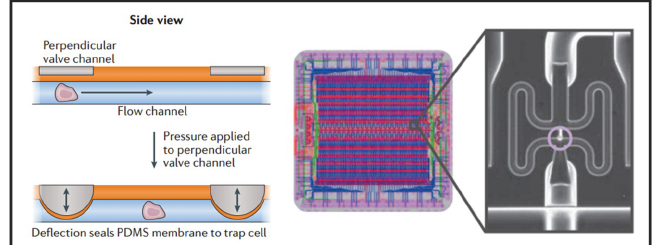
Figure 3. Microfluidic valve single-cell isolation and a design Adapted by permission from